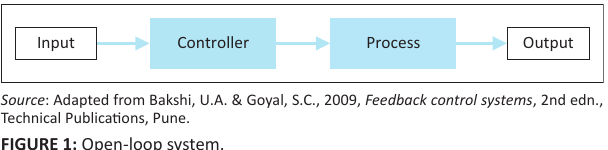
FIGURE 1: Open-loop system.